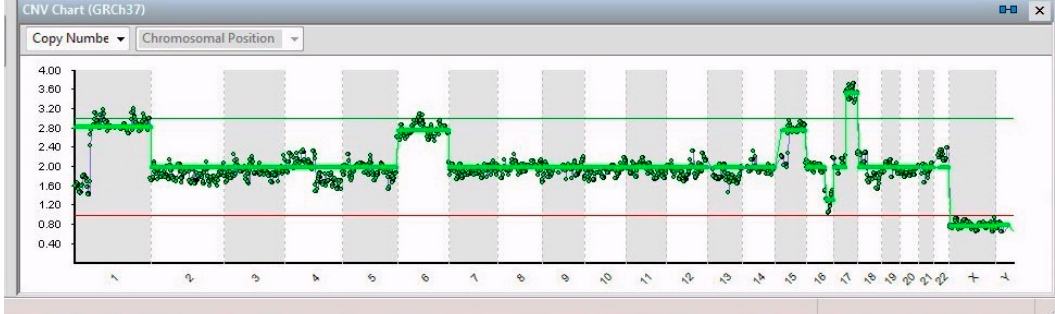
Figure 1. CNV chart related to a single cell from IMR-32 showing, from left to right, partial gain of chromosome 1, total gain of chromosomes 6 and 15, a partial loss of chromosome 16, a partial gain in chromosome 17, and the total loss of the X